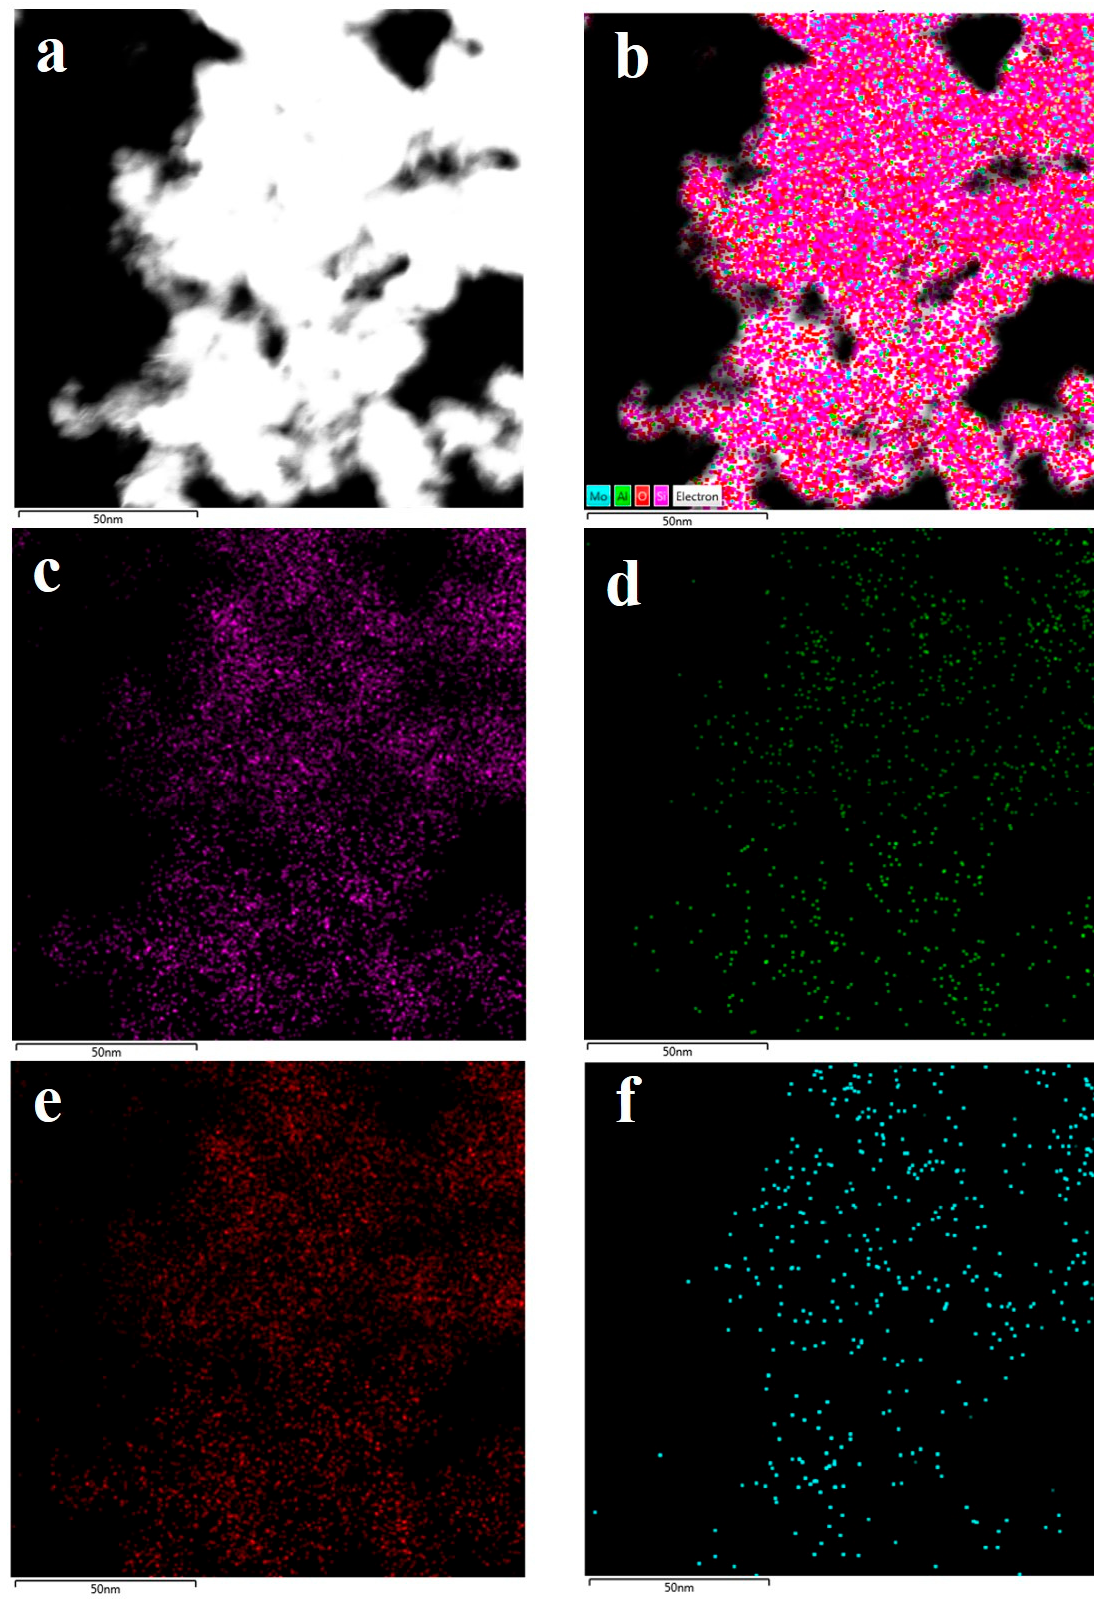
Figure 8. TEM image of 6Mo(C)-HMCM-49 used in the EDS mapping test ( a ) and the corresponding EDS mapping of various elements ( b ), Si ( c ), Al ( d ), O ( e ), and Mo ( f ).